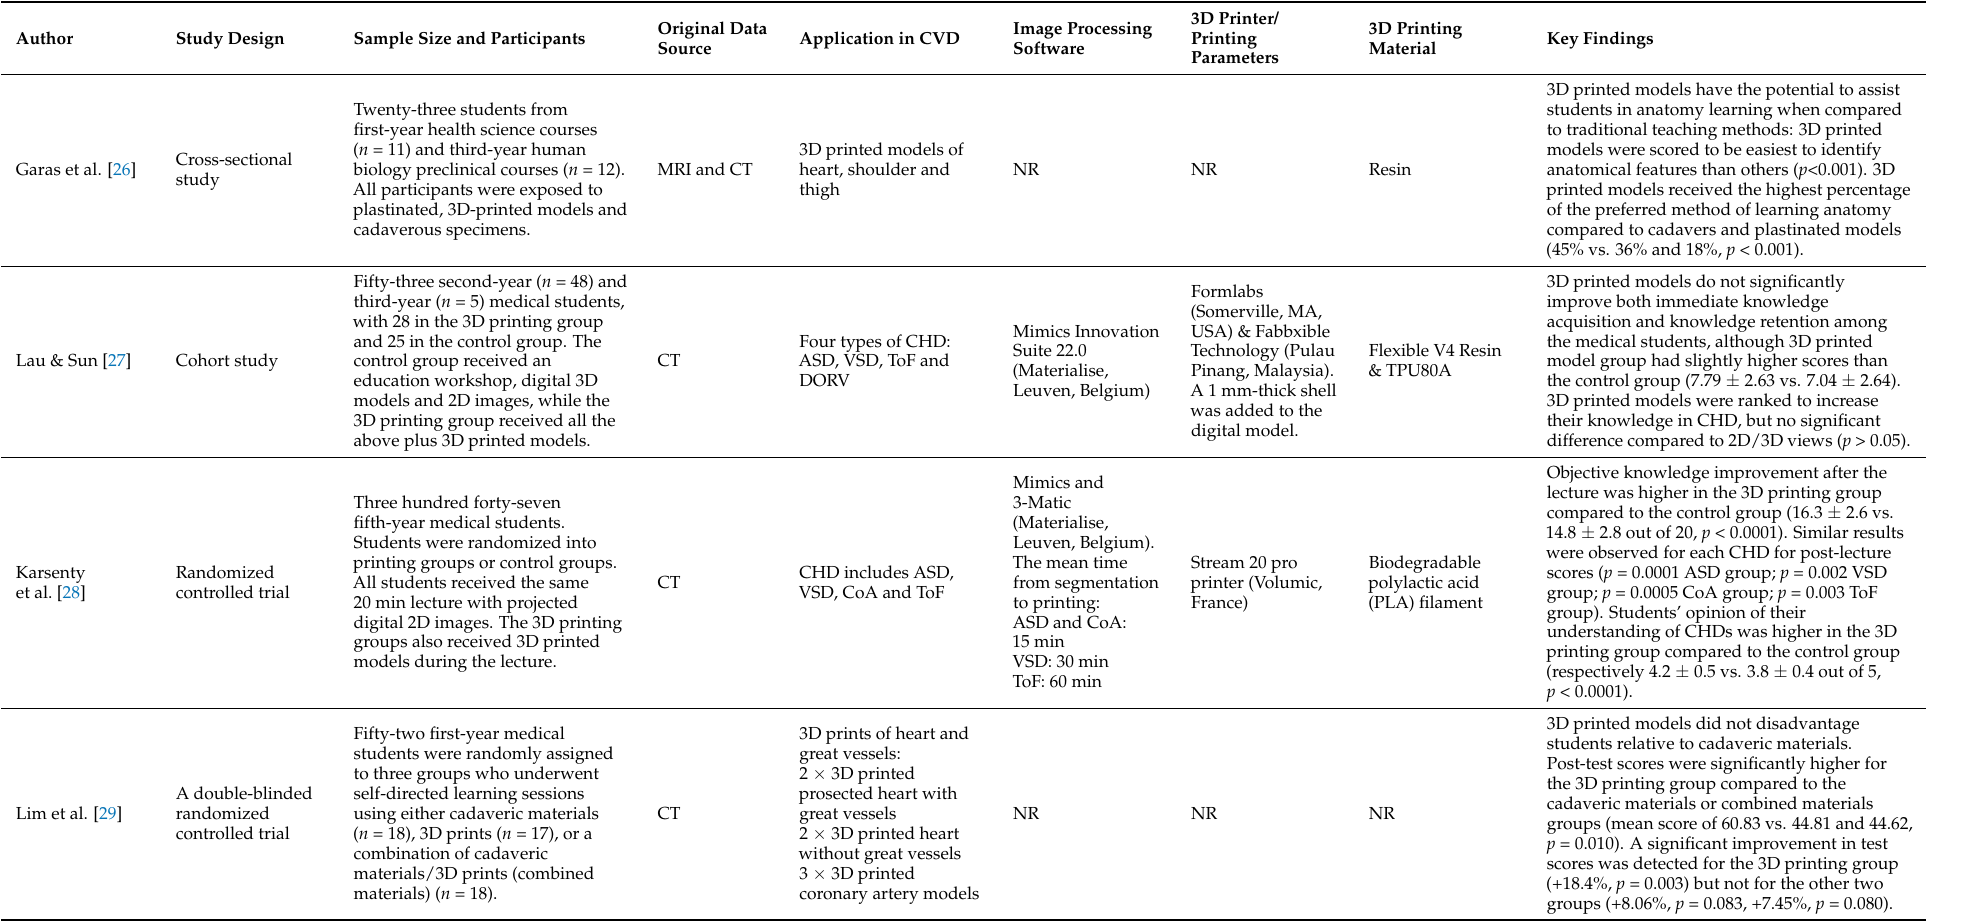
Table 1. Usefulness of 3D printed models in medical and clinical